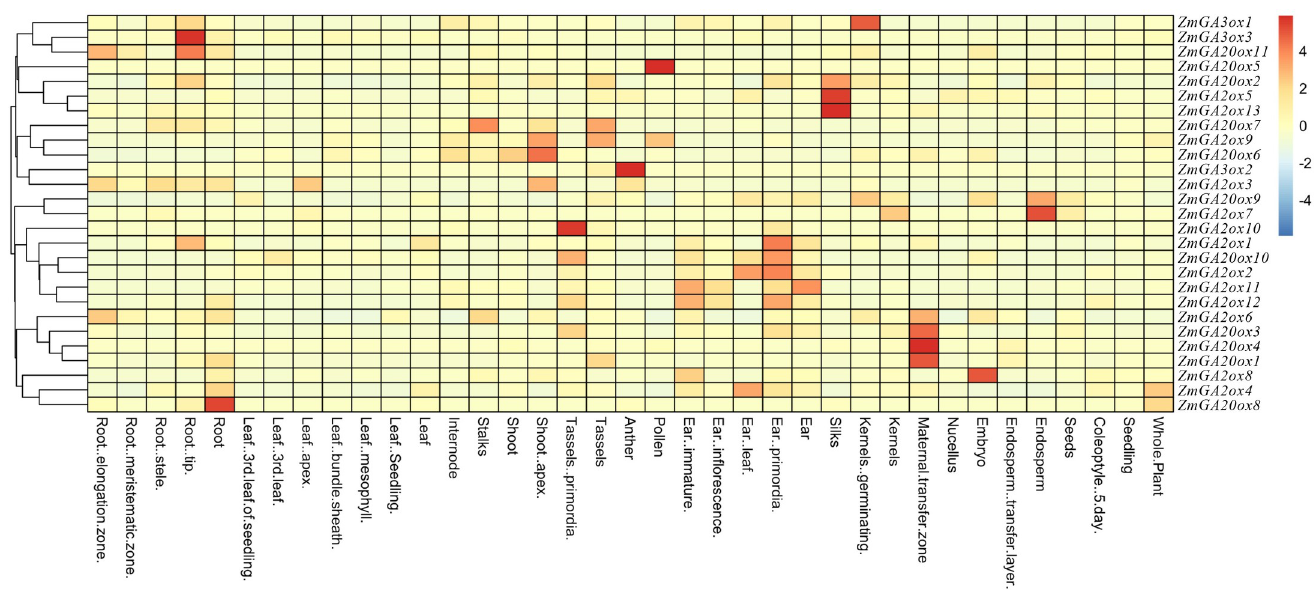
Fig 5. Tissue-specific expression analysis of gibberellin-dioxygenases genes in maize.